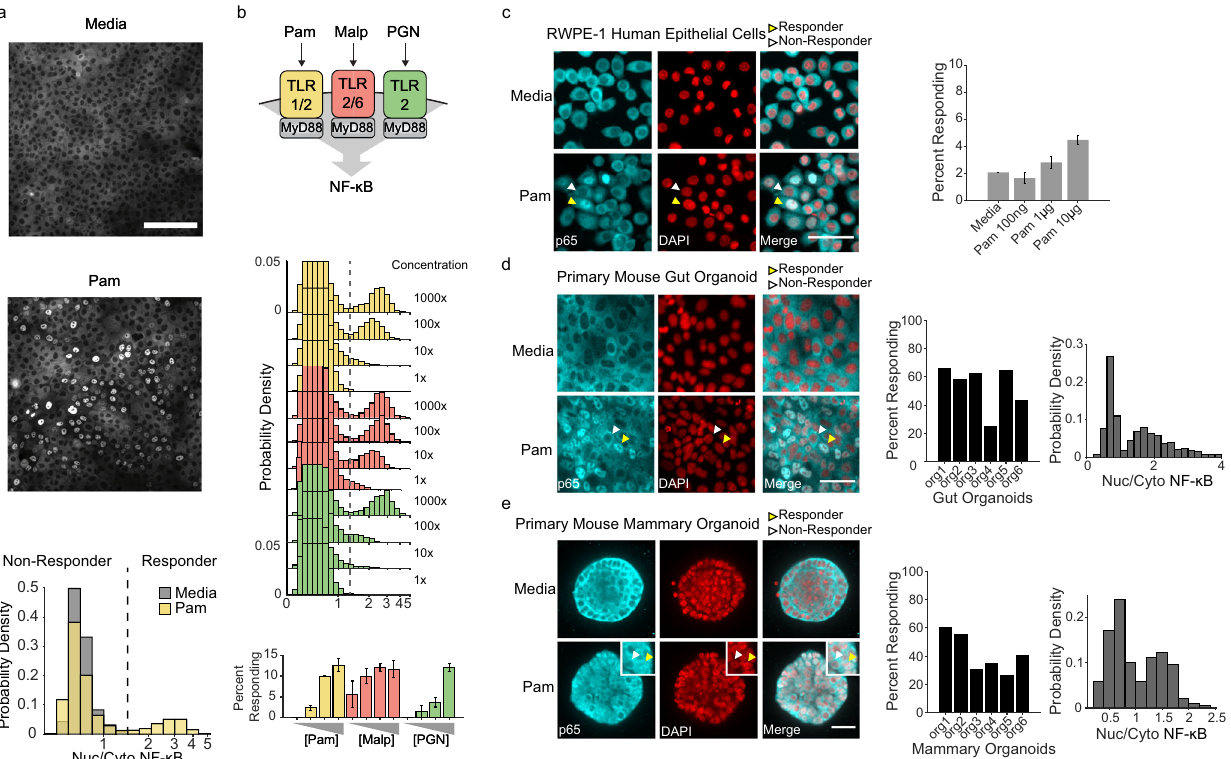
Fig. 2 Pam3CSK4 triggers a capped digital response in primary epithelial cells and organoids. a p65 immuno fl uorescent stain of wild type MCF10A stimulated with media (top) or 1 µ g/ml Pam3CSK4 (bottom) for 30 min. Scale bar, 300 µ m. Histogram shows nuclear/cytoplasmic p65 intensity in logarithmic scale. Cells with nuclear/cytoplasmic p65 ratio greater than media controls were considered responders. b Dose-response curve of WT MCF10A with 30 minutes of Pam3CSK4 (0.01, 0.1, 1, 10 µ g/ml), MALP (0.001, 0.01, 0.1, 1 µ g/ml), or PGN (0.01, 0.1, 1, 10 µ g/ml). Data represent the mean ± SD of three replicates. c Human prostate epithelial cells (RWPE-1) were cultured, treated for 30 mins with 10 µ g/ml Pam3CSK4, fi xed and stained as described in methods. Representative images are shown. Yellow and white arrows indicate examples of responder and non-responder cells respectively. Scale bar, 50 µ m. Percent of cells in monolayer responding to increasing concentrations of Pam3CSK4. Data represent the mean ± SD of four replicates. d Primary mouse gut organoids were cultured as described in methods, treated for 30 mins with 10 µ g/ml Pam3CSK4 and immunostained. Representative images are shown. Scale bar, 100 µ m. Bar plot and histograms show quanti fi cation of percent responding cells in individual organoids and nuclear/ cytoplasmic NF- κ B amplitude of response in combined organoids. e Primary mouse mammary organoids were cultured as described in methods, treated for 30 mins with 10 µ g/ml Pam3CSK4 and immunostained. Representative images of three independent replicates are shown. Scale bar, 30 µ m. Bar plot and histograms show quanti fi cation as in panel d